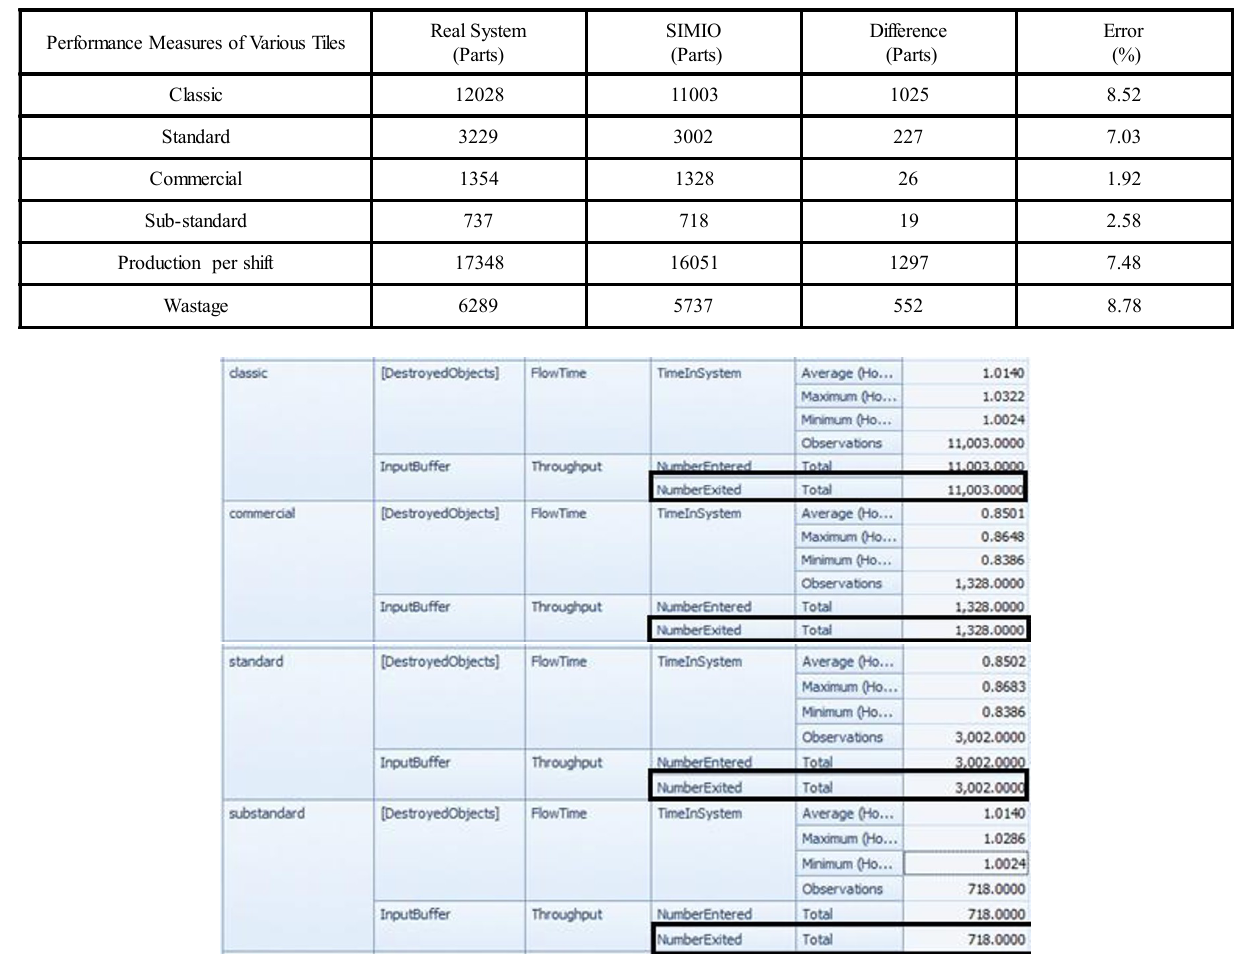
TABLE 9. COMPARISON OF REAL SYSTEM AND SIMIO RESULTS